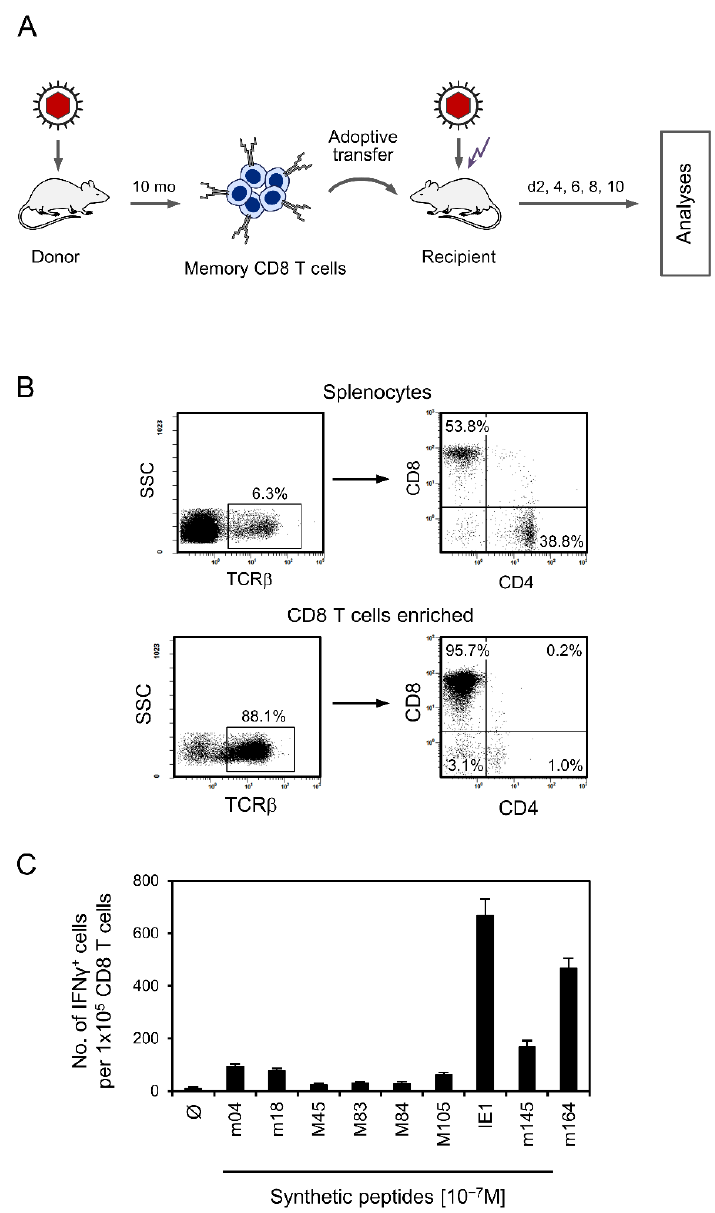
Figure 1. Characterization of the donor CD8 T ‐ cell population used for CD8 ‐ AT. ( A ) Sketch of the experimental protocol. Polyclonal CD8 T cells were isolated from the spleen of donor BALB/c mice primed 10 months earlier by infection with mCMV. The cells were transferred into immunocompromised recipient BALB/c mice. (Flash symbol) γ‐irradiation was applied to both recipients of CD8 ‐ AT and no ‐ transfer control mice. ( B ) Cytofluorometric analysis documenting the enrichment of CD8 T cells by positive immunomagnetic cell sorting; (SSC) sideward scatter. ( C ) Frequencies of memory CD8 T cells specific for the viral epitopes indicated. Bars represent the frequencies of cells stimulated by viral antigenic peptides to secrete IFN γ in an ELISpot assay. Error bars represent the 95% confidence intervals.